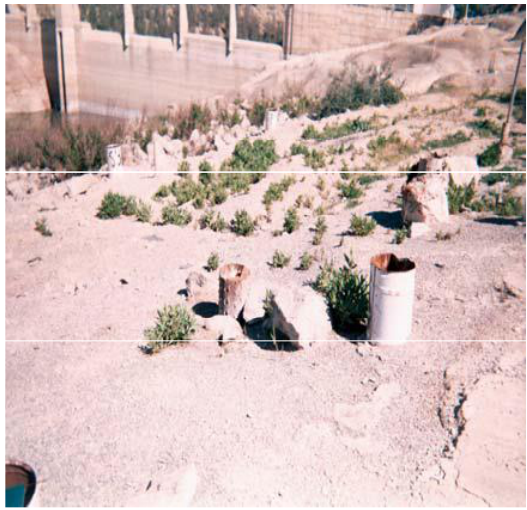
Figure 21. Location of the boreholes of part of the injection